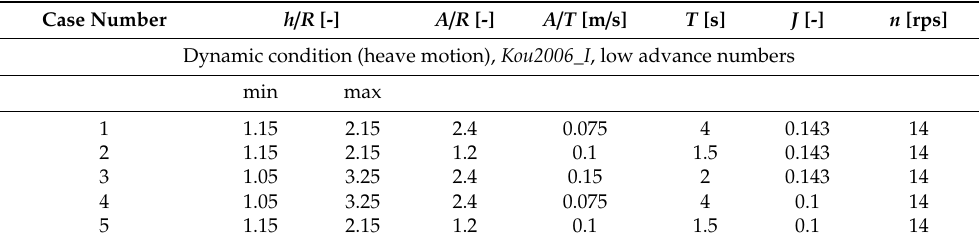
Table 2. Di ff erent experimental condition used for comparison between the simulation model and experimental results.